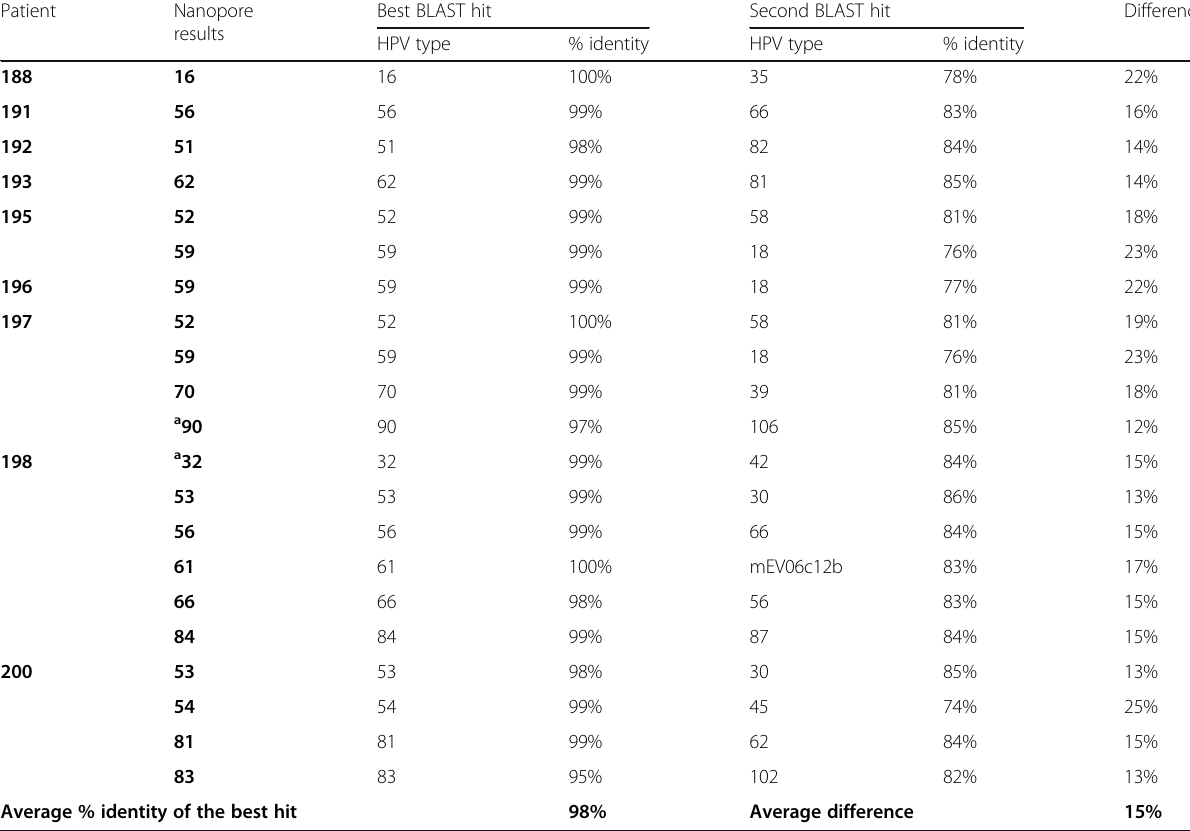
Table 7 Percentage of identity of Nanopore consensus sequences to HPV reference genomes (Continued) Patient